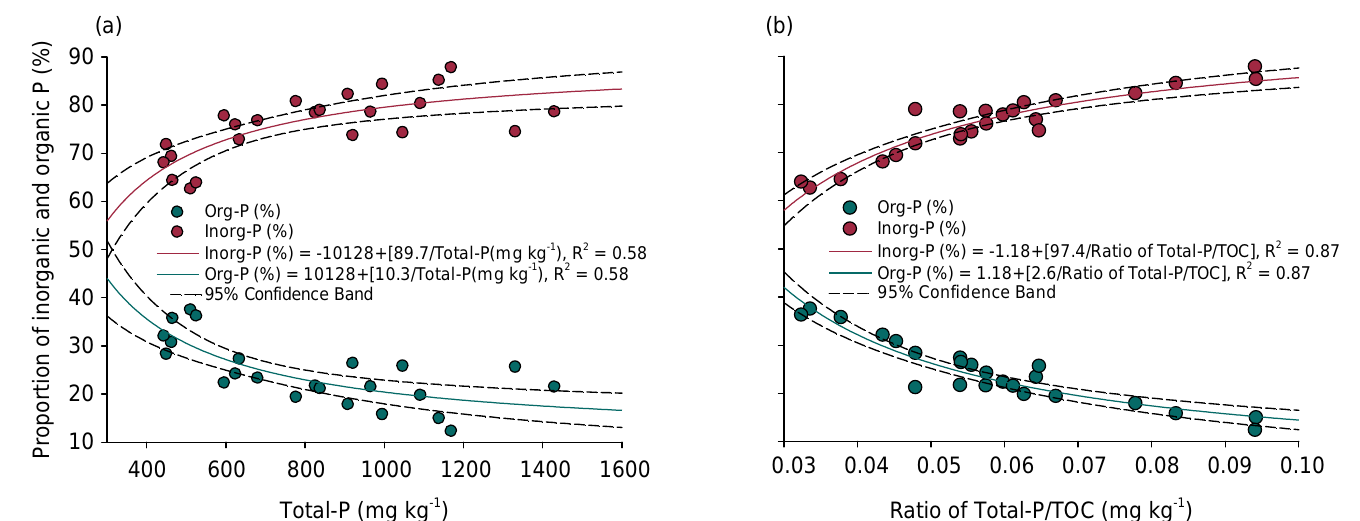
Figure 3. Effect of increase in the total-P content (a) and increase in the ratio total-P/TOC (b) in the soil and the proportion of inorganic and organic P.